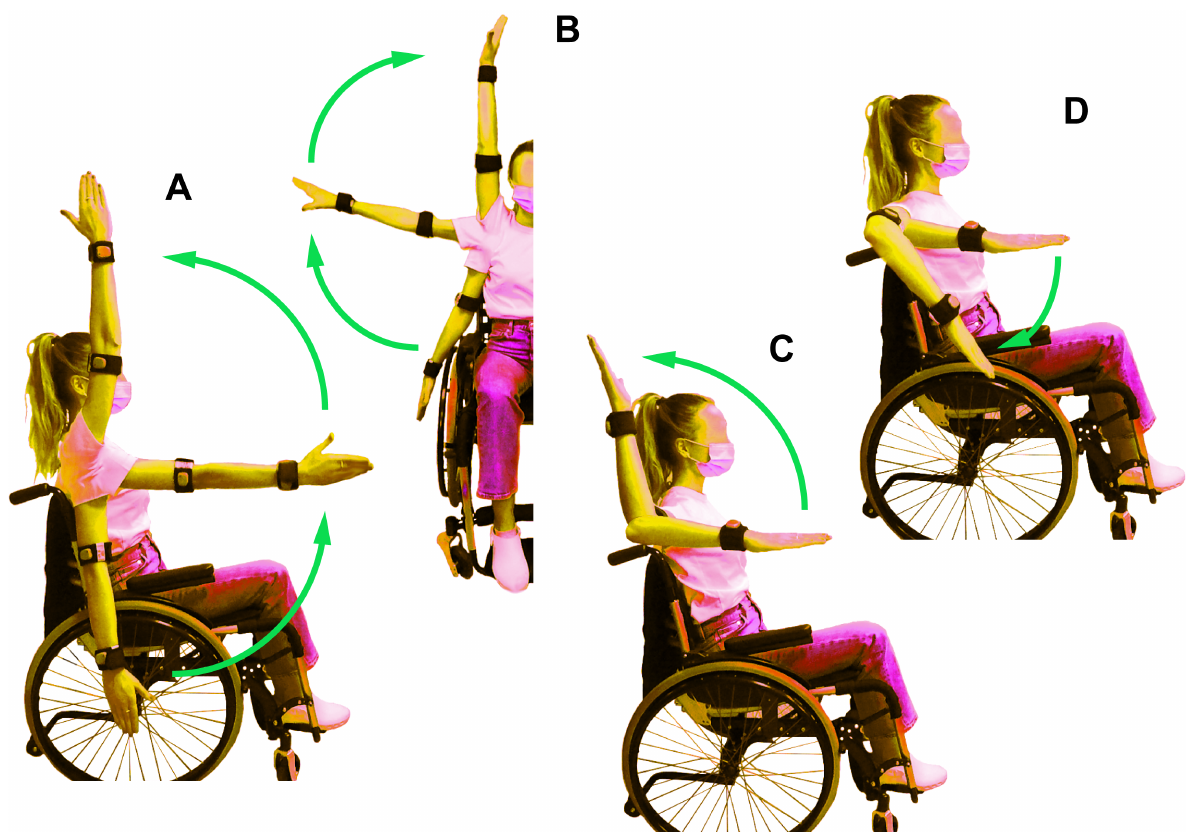
Figure 1. The four recorded active shoulder maneuvers: forward flexion ( A ), abduction ( B ), external rotation ( C ) and internal rotation ( D